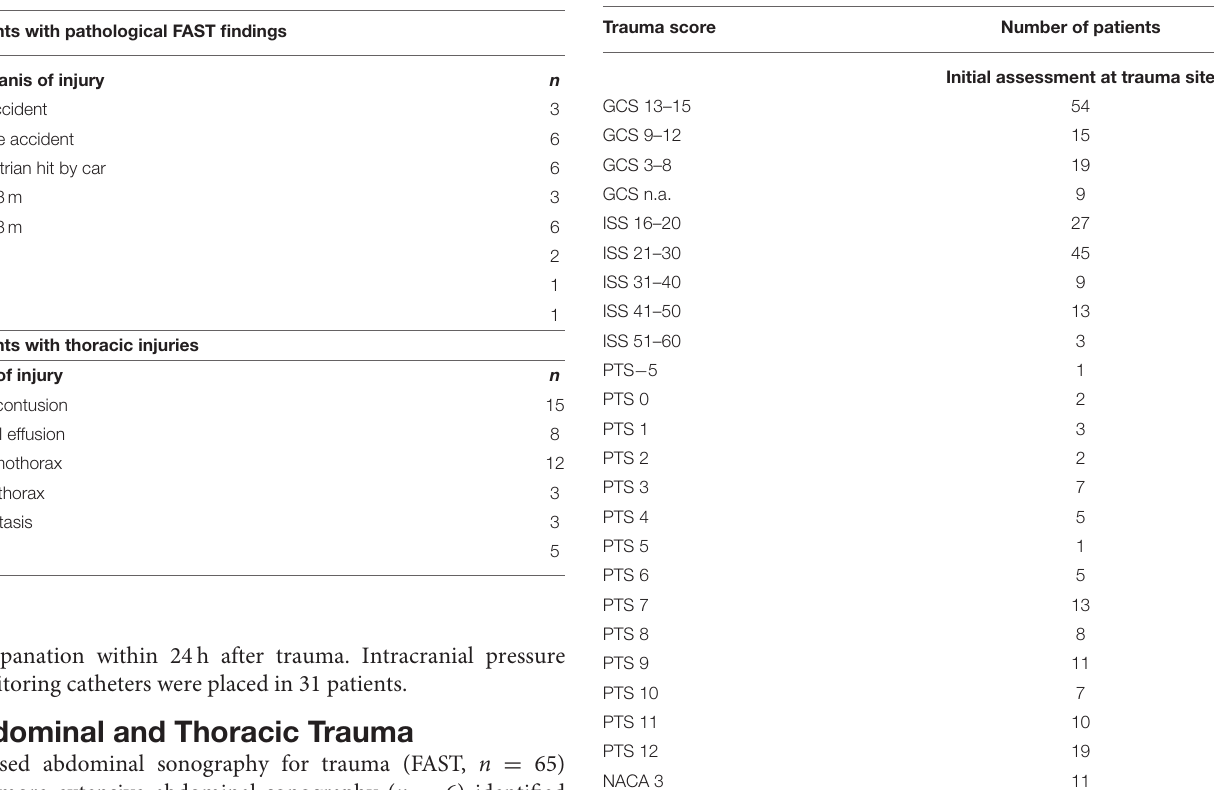
TABLE 2 | Different trauma scores GCS, ISS, and PTS of the patients in this study are listed